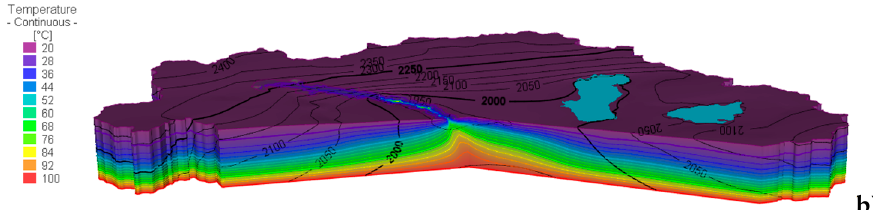
Figure 11. Hydraulic head and temperature distribution for ( a ) interaction of topography-driven groundwater flow and Convective 1, scenario II; and ( b ) interaction of topography-driven groundwater flow and Convective 2, scenario III. Vertical exaggeration of the scale is 5:1.